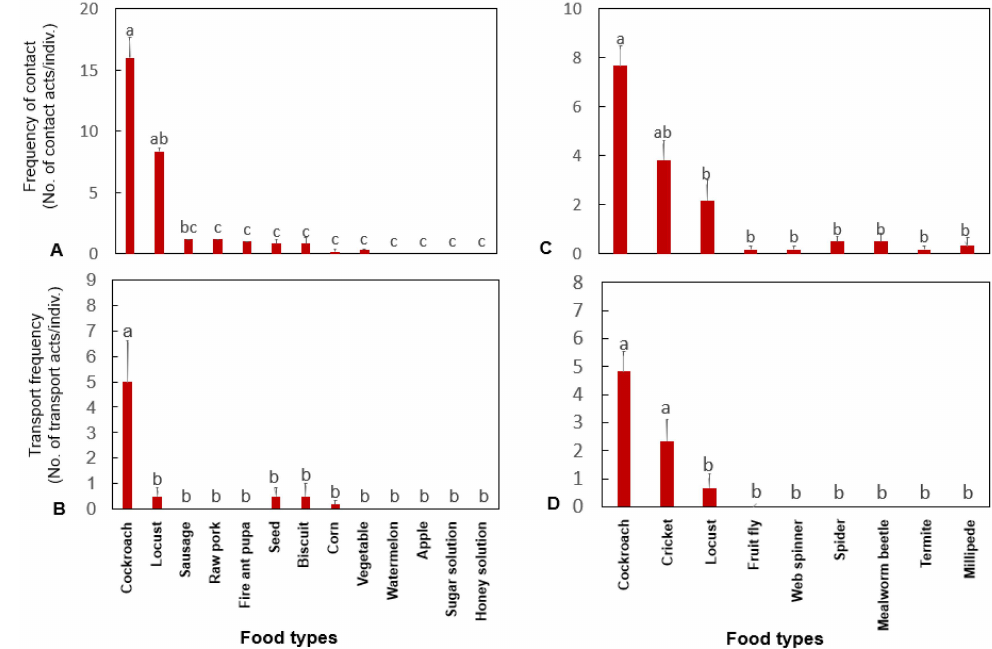
Figure 2. The frequency of touch ( A , C ) and transport ( B , D ) by H. venator for different food types and arthropods (mean ± SE). Bars with the same letter are not significantly different at the 0.05 level (Kruskal–Wallis